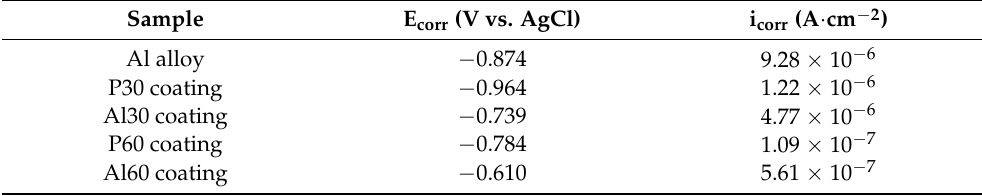
Figure 12. Potentiodynamic polarization curves in 5 wt % NaCl solution (pH = 3.1–3.3) for uncoated and PEO coated. Table 2. Fitting results of potentiodynamic polarization curves in 5 wt % NaCl solution (pH = 3.1–3.3) for uncoated and PEO coated.